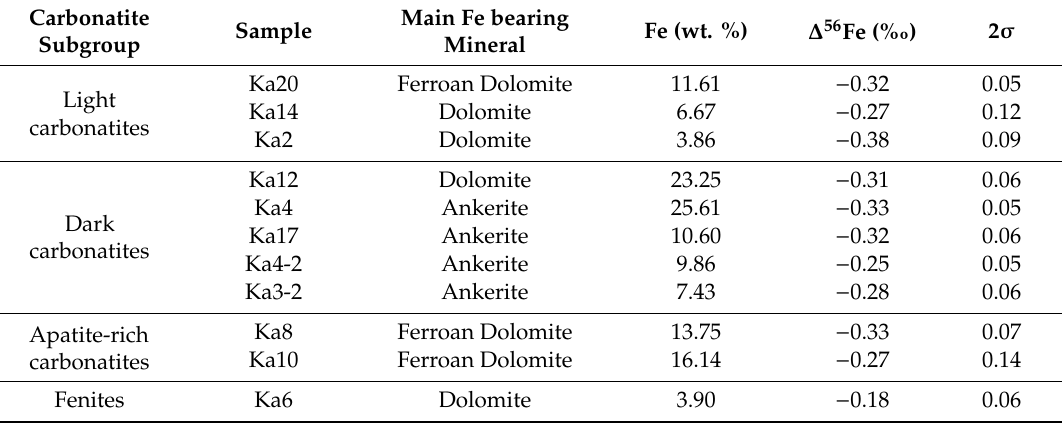
Table A4. Iron isotopic compositions of the Kangankunde carbonatites and